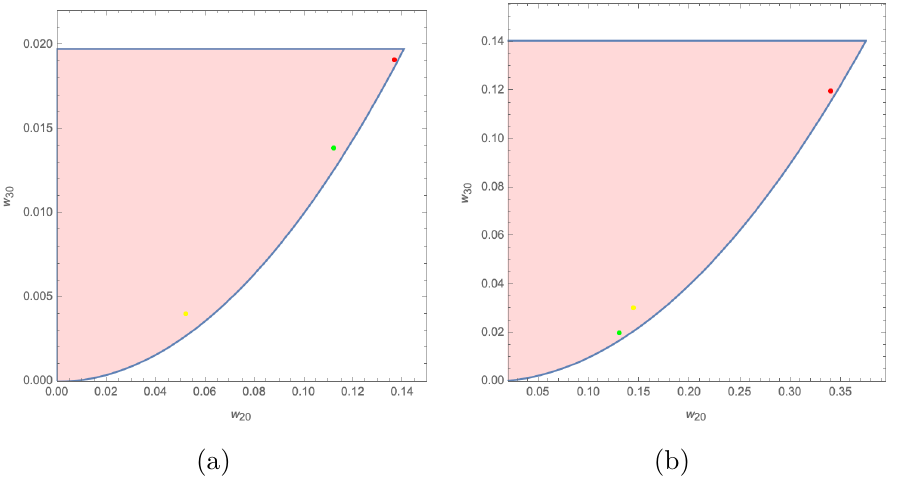
Figure 9. Nonlinear constraints in 3-channel case. Red is the closed string, yellow is 1-loop φ 4 and green is the pion S-matrix at s = 0 . 35 from the bootstrap. (a) 3-channel (b) 2-channel. 0